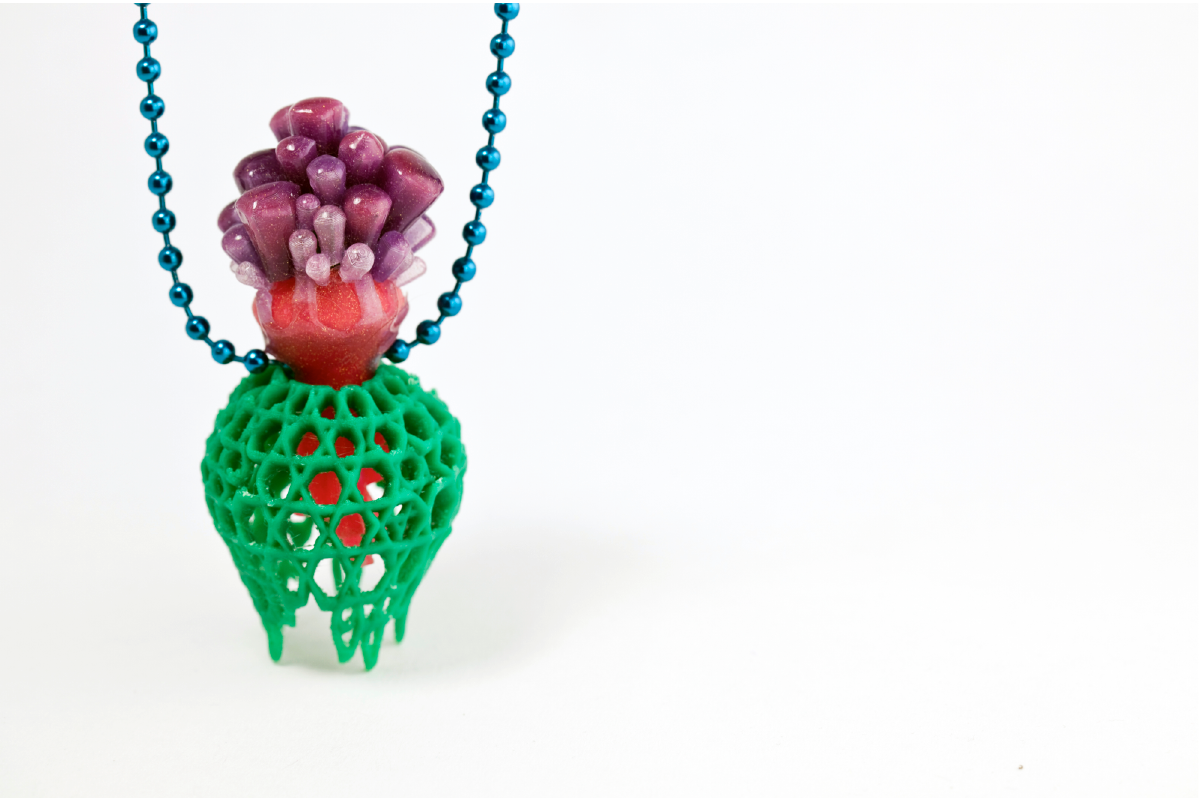
Figure 13 | Hyperhive: Hypertilt Pendant (3 of 5), Katharina Vones (2015).